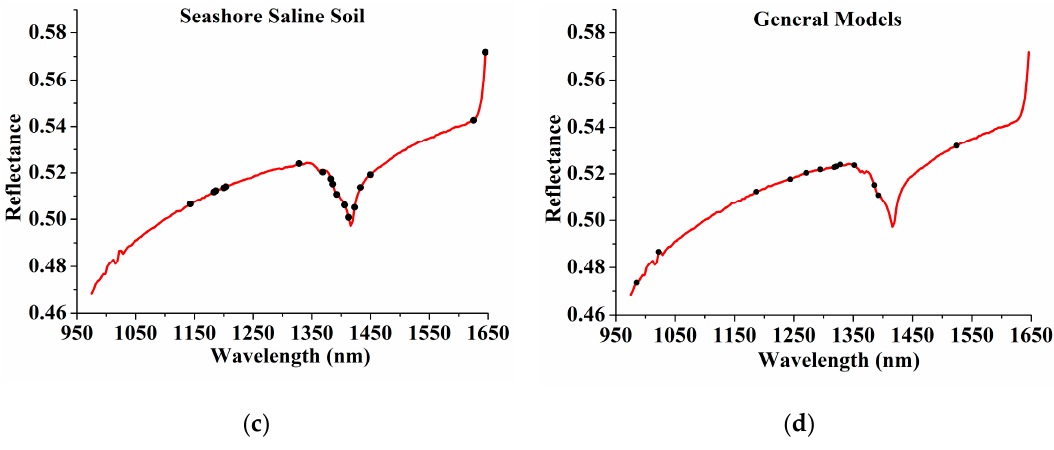
Figure 8. The variables selected by SPA (shown in circle markers) corresponding to raw spectra for paddy soil, red soil, seashore saline soil and general models were presented in ( a – d ), respectively. The prediction results of soil TN using different sample sets and input variables are listed in